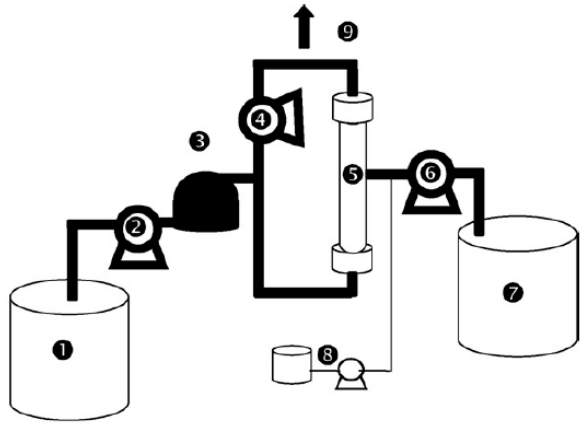
Figure 1. Pilot plant “image” (1—feed tank; 2—feed pump; 3—pre-filter; 4—recirculating pump; 5—membrane module; 6—backwashing pump; 7—purified water tank for backwash; 8—chemical cleaning part; 9—purge).